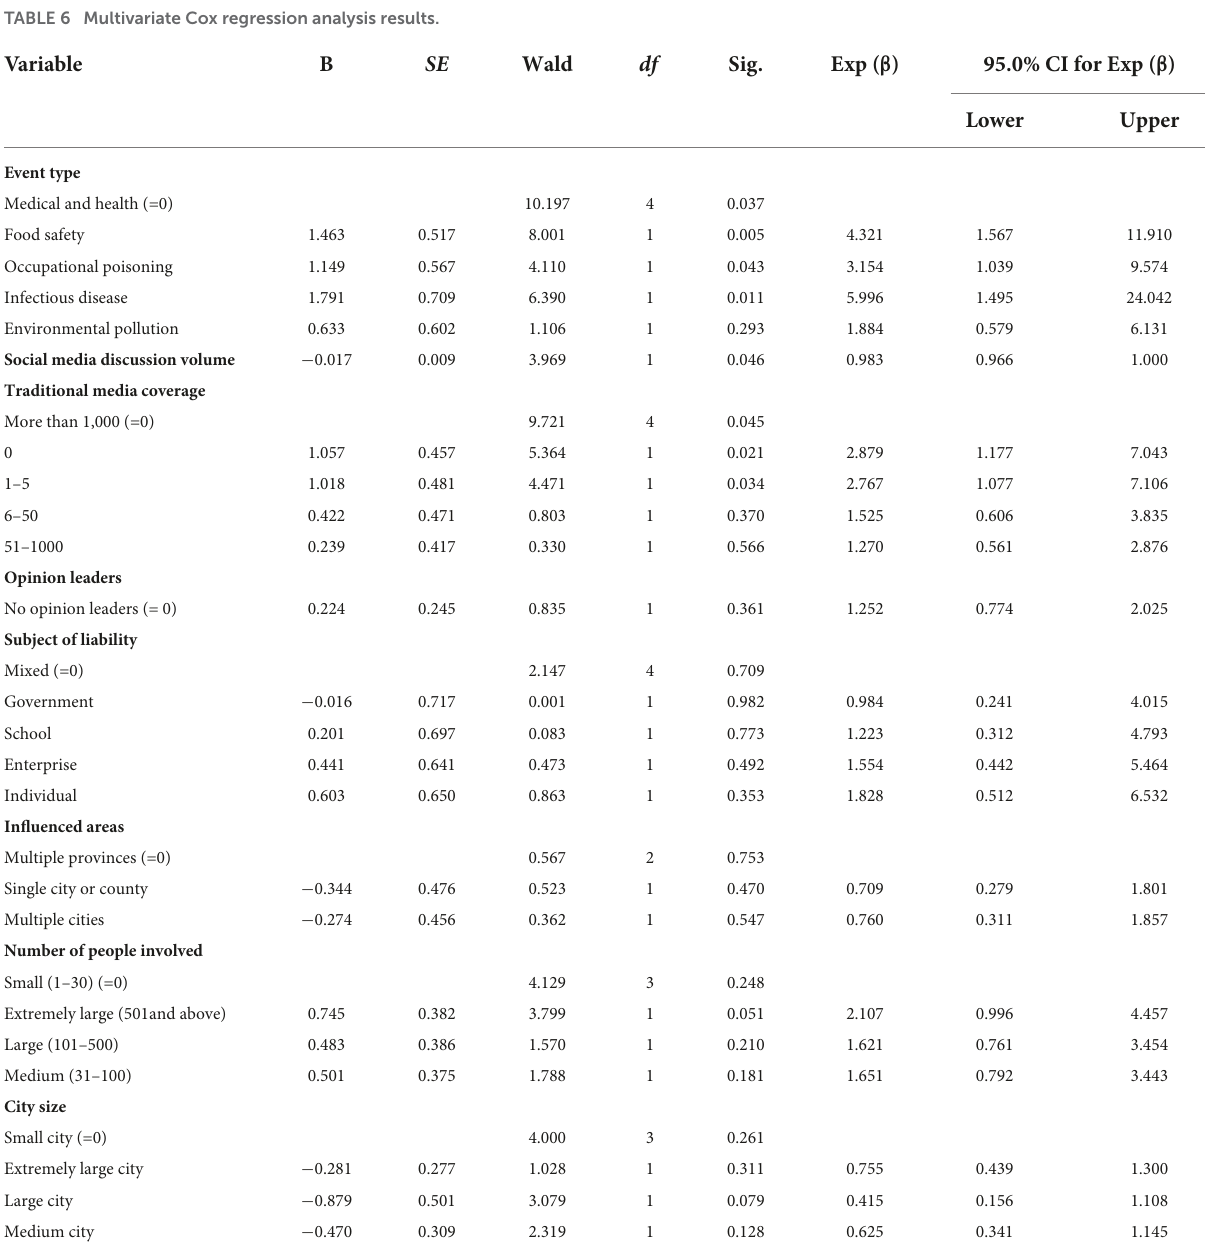
TABLE 6 Multivariate Cox regression analysis